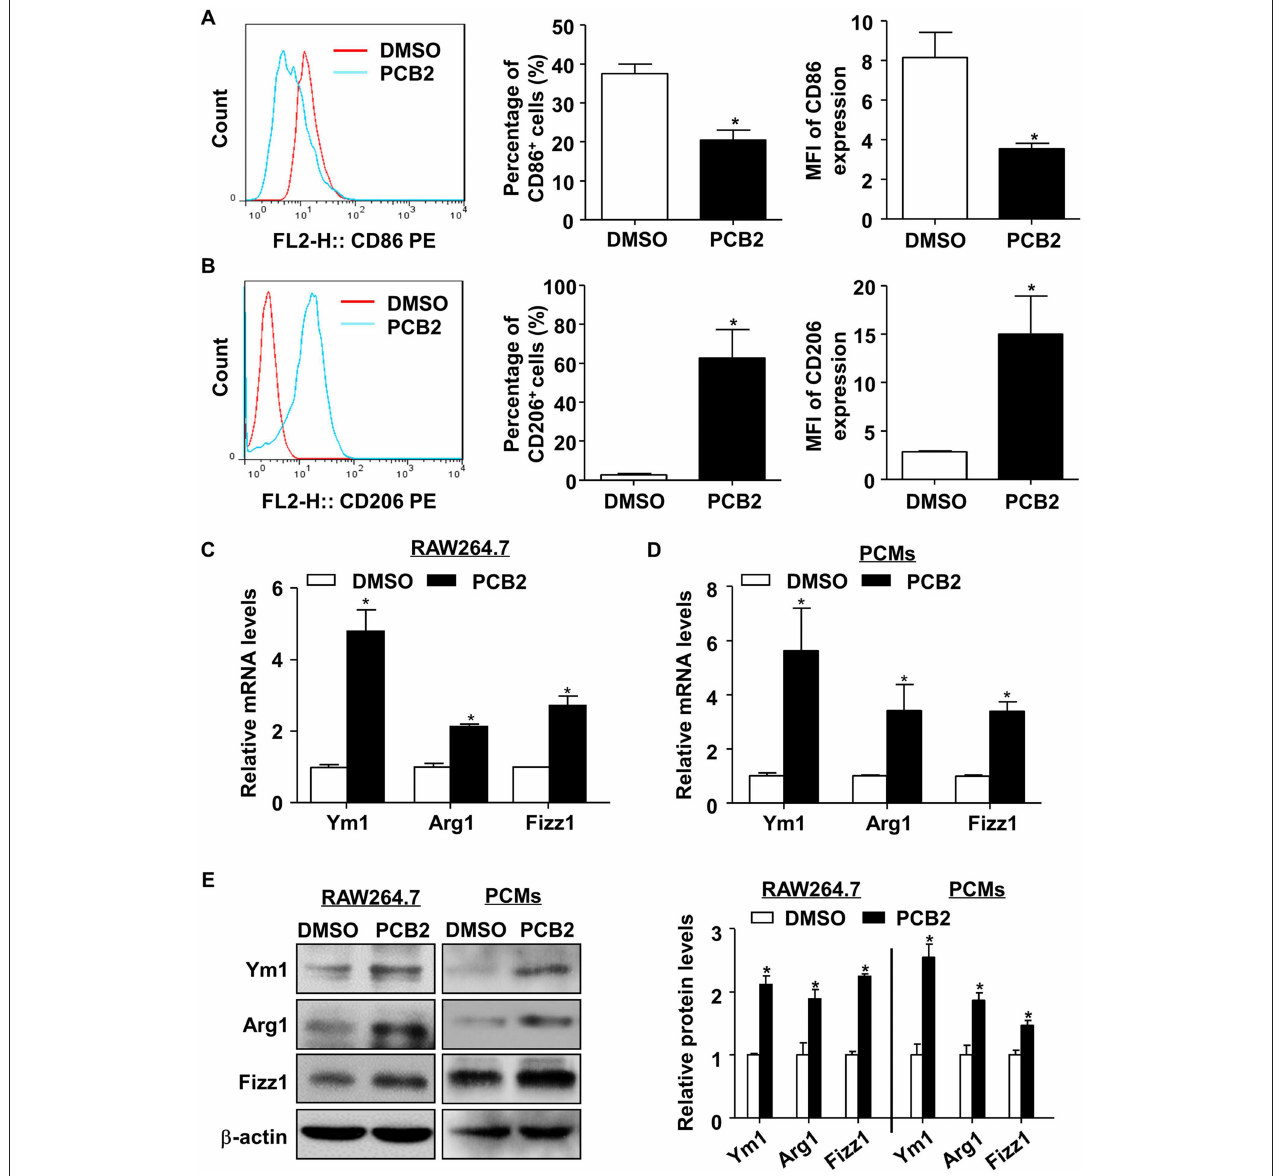
FIGURE 1 | PCB2 promoted macrophage M2 polarization. RAW264.7 cells were incubated with PCB2 (10 µ M) for 24h and DMSO was used as vehicle control. The flow cytometry analysis was performed to evaluate the expressions of CD86 (A) and CD206 (B) . Representative histograms were obtained by flow cytometry analysis. Percentage of CD86 + or CD206 + macrophages and mean fluorescence intensity (MFI) of CD86 or CD206 expression on macrophages were quantified. RAW264.7 cells (C) and PCMs isolated from C57BL/6J mice (D) were incubated with PCB2 (10 µ M) for 24h. Total RNA was extracted and subjected to qRT-PCR for the assessment of Ym1, Arg1, and Fizz1 levels. (E) Cells lysates were analyzed for the protein levels of Ym1, Arg1, and Fizz1 by using western blotting in RAW264.7 cells and PCMs. Quantification of Ym1, Arg1, and Fizz1 protein levels. Data were shown as mean ± SEM, n = 3–6, * P < 0.05 vs. vehicle (DMSO).